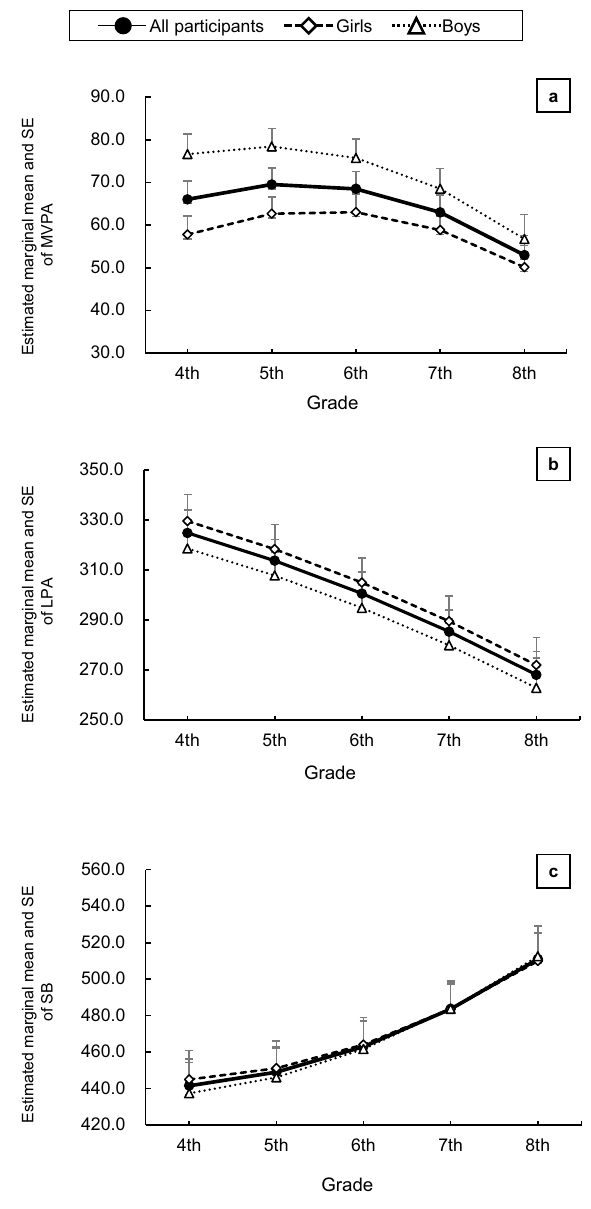
Figure 1. Quadratic trends for the different types of physical activity in linear mixed models I and II. ( a ) Moderate-to-vigorous intensity physical activity (MVPA); ( b ) light physical activity (LPA); ( c ) sedentary behavior (SB). ChAnges are expressed as estimated marginal means. The trends in linear mixed model I (solid line) were adjusted for body fat and accelerometer wearing time. The trends in linear mixed model II (dashed line and dotted line indicating girls and boys, respectively) were determined by adding the variables sex and the interaction between sex and grade. SE standard